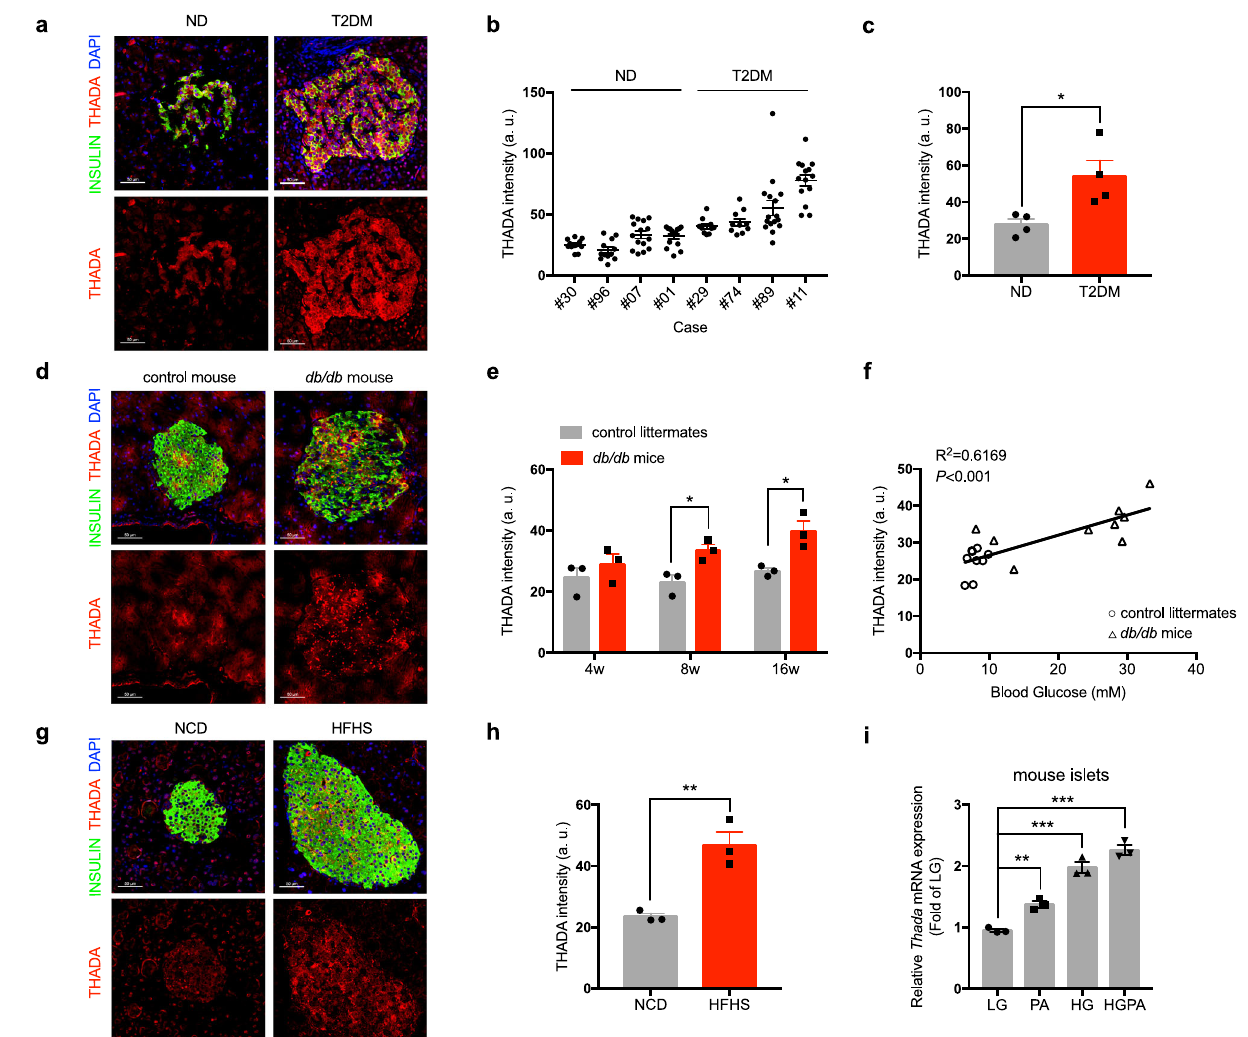
Fig.1|THADAisactivatedinisletsofT2DMpatientsandmice.a Representative pancreatic sections from non-diabetes (ND) and type 2 diabetes mellitus (T2DM) participants stained for insulin (green), THADA (red), and DAPI (blue). Scale bars, 50 μ m. b THADAintensityofeachisletinNDandT2DMparticipants( n =10for#29 and #74, n =12 for #96, n =13 for #30, n =14 for #01 and #11, n =15 for #07, n =16 for #89). c Quanti fi cation of mean THADA intensities in ND and T2DM individuals ( n =4). d Representativepancreaticsectionsfrom16-week-old db/db miceandtheir wild-type control littermates stained for insulin (green), THADA (red), and DAPI (blue). Scale bars, 50 μ m. e Quanti fi cation of THADA intensities in control litter- matesand db/db miceat4,8,and16weeksofage( n =3). f Linearregressionanalysis of islet THADA intensities and blood glucose levels in control littermates (circles)